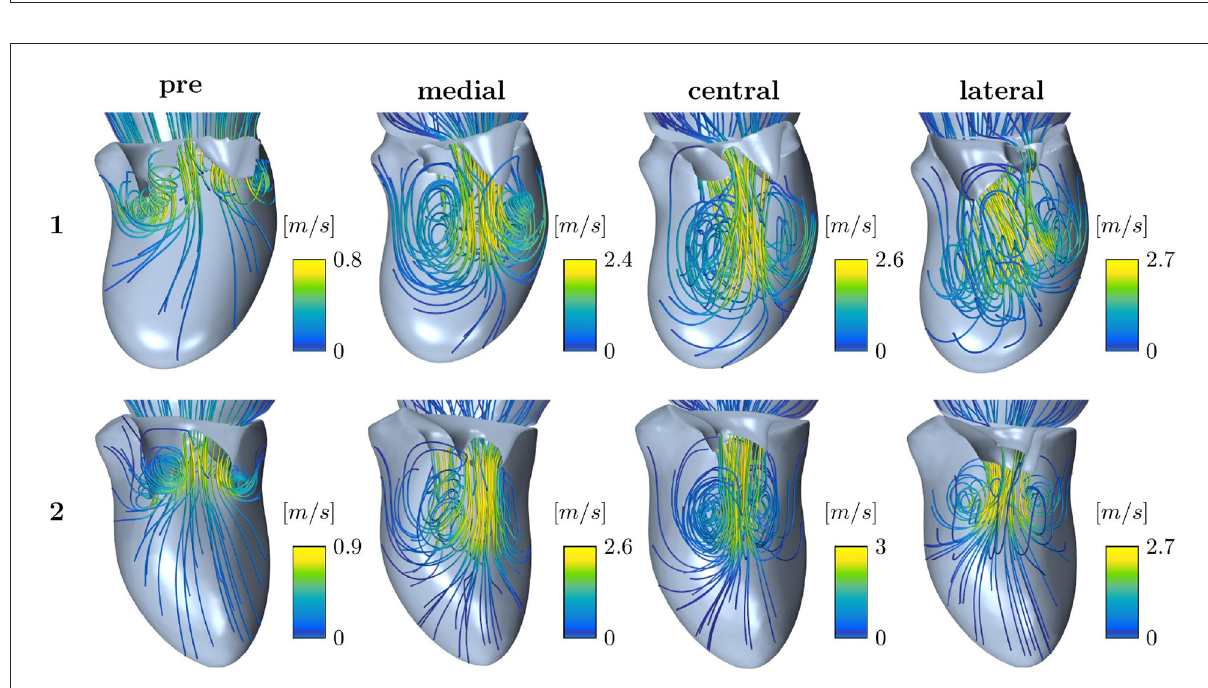
FIGURE9 Streamline representation of the flow field for pre-interventional conditions and after virtual TEER at medial, central, and lateral device positions, respectively, for Patients 1 and 2.